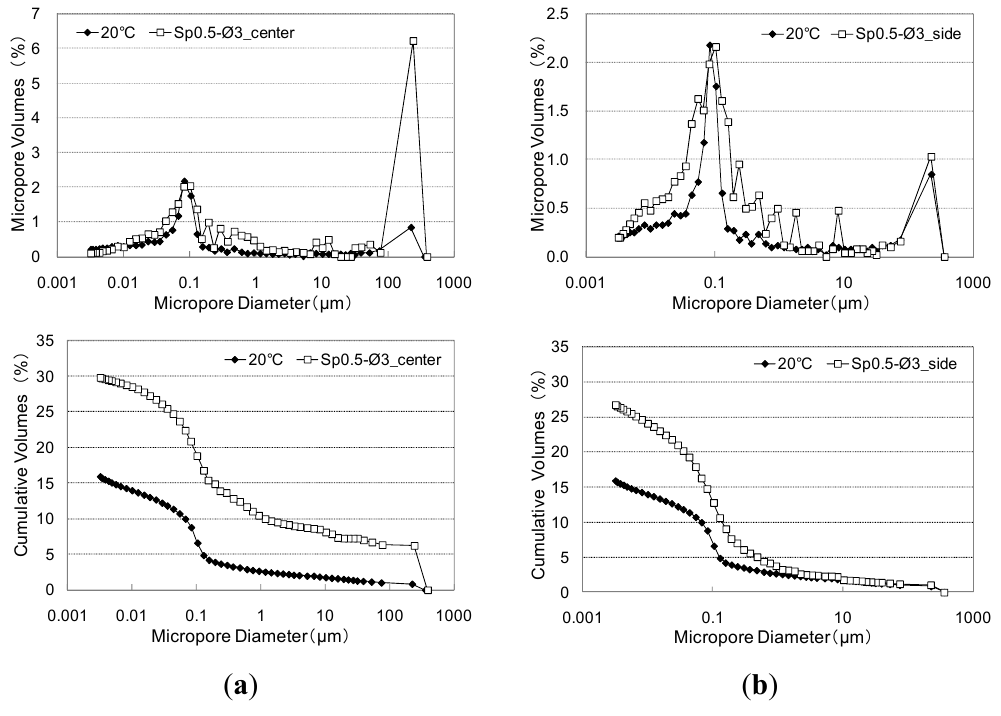
Figure 20. Changes in the pore structure of cementitious joint through induction heating. ( a ) Sp0.5–ø3_2.25 kW (center); ( b ) Sp0.5–ø3_2.25 kW